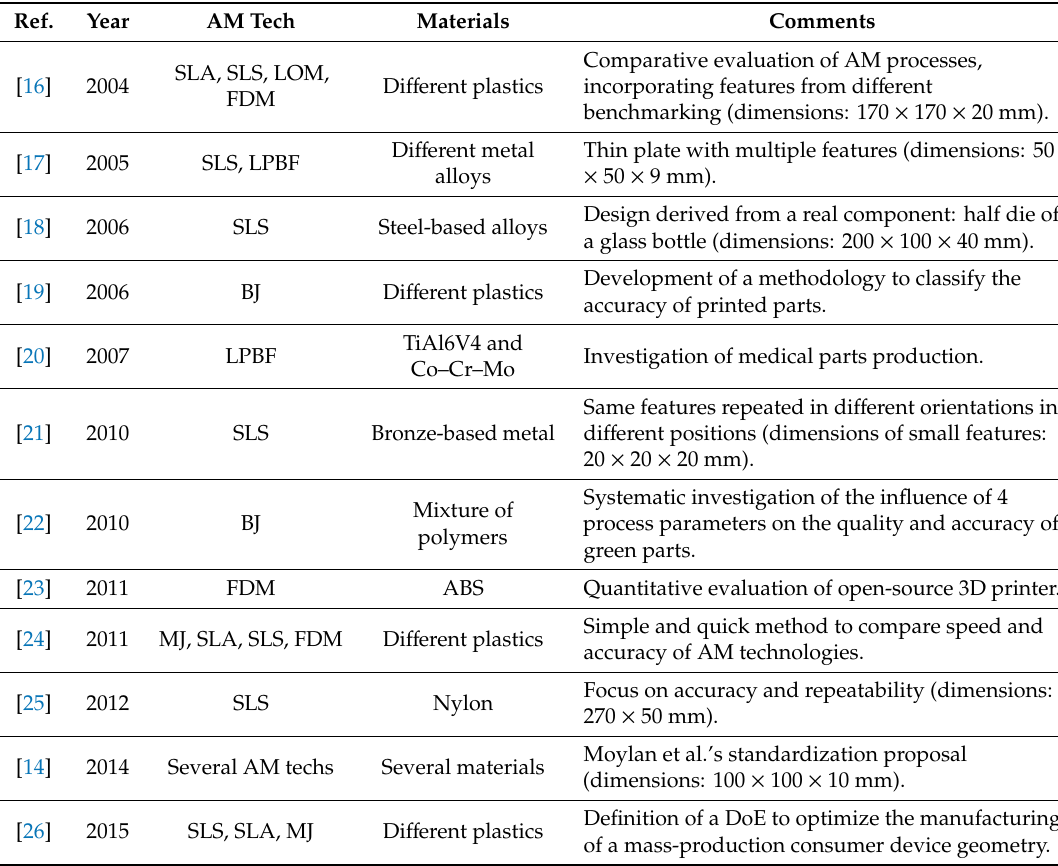
Examples of benchmarking of additive manufacturing (AM) technologies. For the AM technologies: SLA, stereolithography; SLS, selective laser sintering; LOM, laminated object manufacturing; FDM, fused deposition modeling. Ref. AM Tech Materials Comments Comparative evaluation of AM processes, Di ff erent plastics incorporating features from di ff erent benchmarking (dimensions: 170 × 170 × 20 mm). Thin plate with multiple features (dimensions: 50 × 50 × 9 mm). alloys Design derived from a real component: half die of Steel-based alloys a glass bottle (dimensions: 200 × 100 × 40 mm). Development of a methodology to classify the accuracy of printed parts. Investigation of medical parts production. Same features repeated in di ff erent orientations in di ff erent positions (dimensions of small features: 20 × 20 × 20 mm). Systematic investigation of the influence of 4 process parameters on the quality and accuracy of green parts. Quantitative evaluation of open-source 3D printer. Simple and quick method to compare speed and accuracy of AM technologies. Focus on accuracy and repeatability (dimensions: Nylon 270 × 50 mm). Moylan et al.’s standardization proposal Several materials (dimensions: 100 × 100 × 10 mm). Definition of a DoE to optimize the manufacturing of a mass-production consumer device